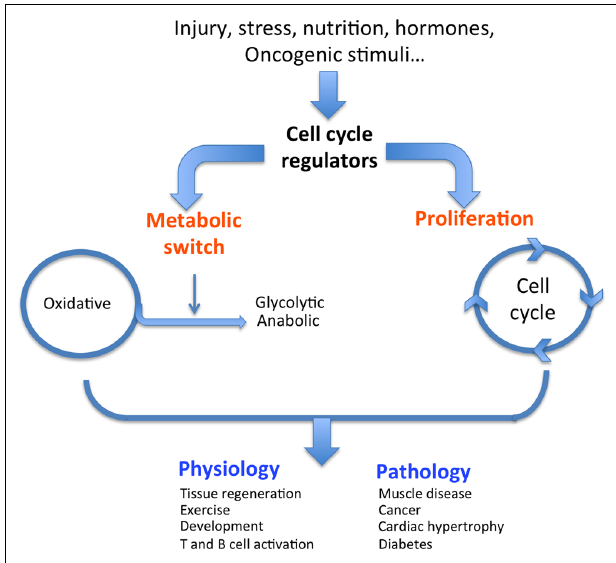
FIGURE 1 | Dual role of cell cycle regulators. In response to external stimuli such as oncogenes, nutrition, or hormones, cell cycle regulators trigger both a classical proliferative burst and an adapted metabolic response (switch from oxidative to glycolytic), ultimately resulting in the physiological or pathological